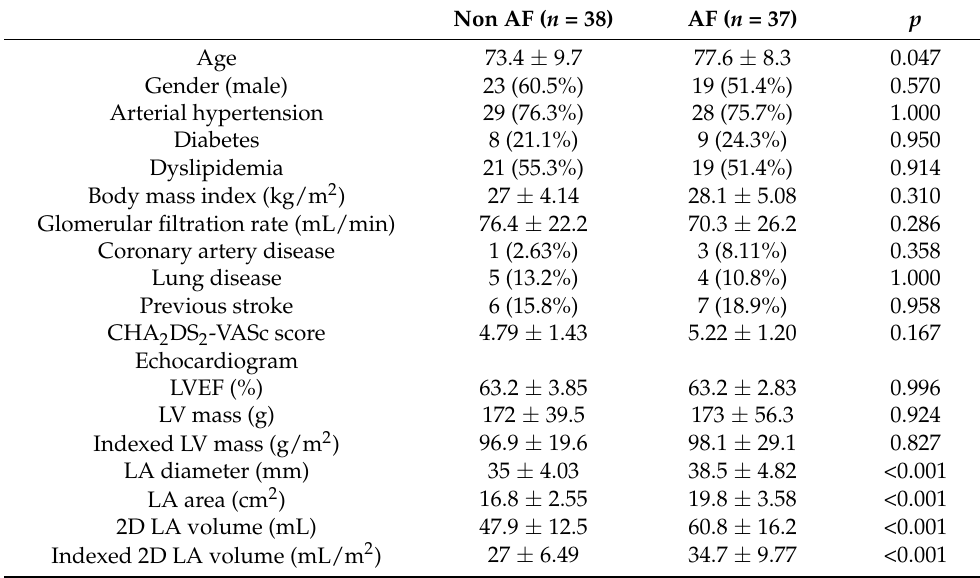
Table 1. Clinical characteristics and echocardiographic parameters of patients with or without atrial